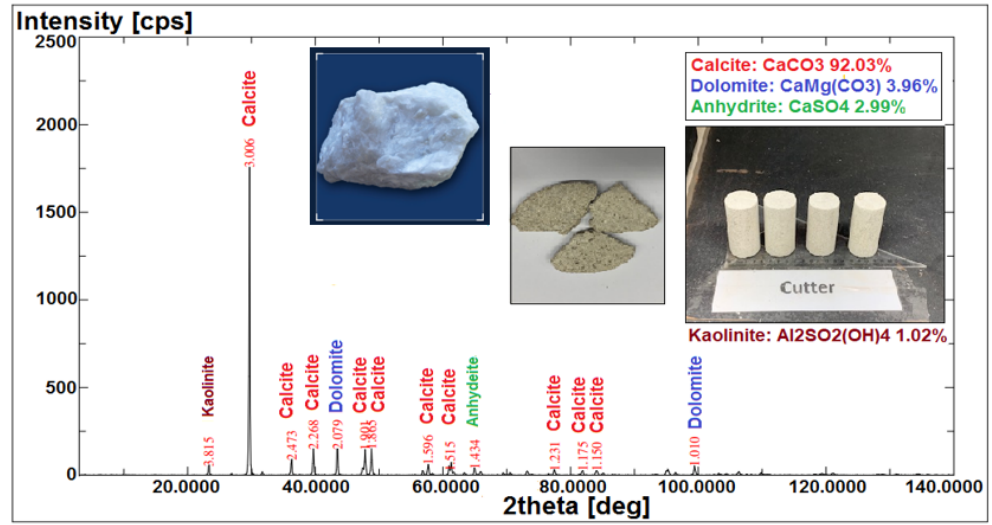
Figure 11. Qualitative analysis of minerals in Indiana limestone (ILS) using XRF and XRD analysis. Permeability